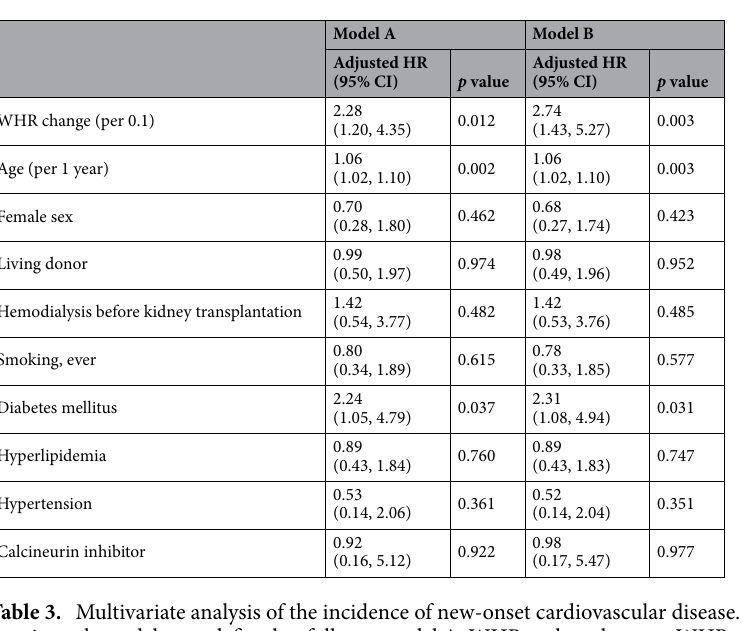
Table 3. Multivariate analysis of the incidence of new-onset cardiovascular disease. WHR changes at the nth year in each model were defined as follows: model A: WHR at the nth year—WHR at baseline. model B: WHR at the nth year—WHR at the (n − 1)th year.